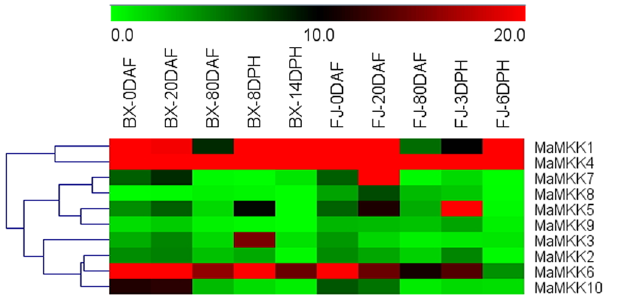
Figure 7. Expression profiles of banana MAPKKs in different stages of fruit development and ripening in BX and FJ varieties. The heat map was constructed according to the FPKM value of banana RNA-seq data. Changes in gene expression are shown in color as the scale.